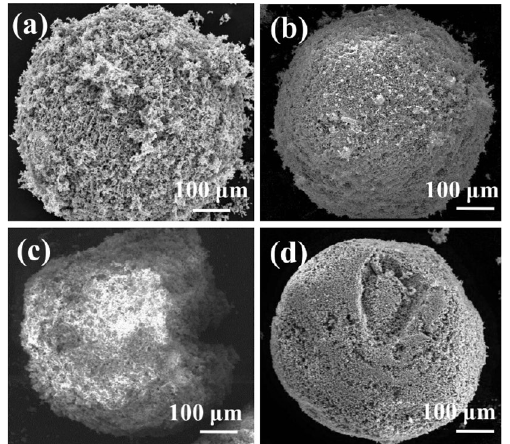
Figure 6. SEM images of the monodispersed single-component ( a ) Mo, ( b ) Si, ( c ) MoB, ( d ) TiC particles by FD-POEM.